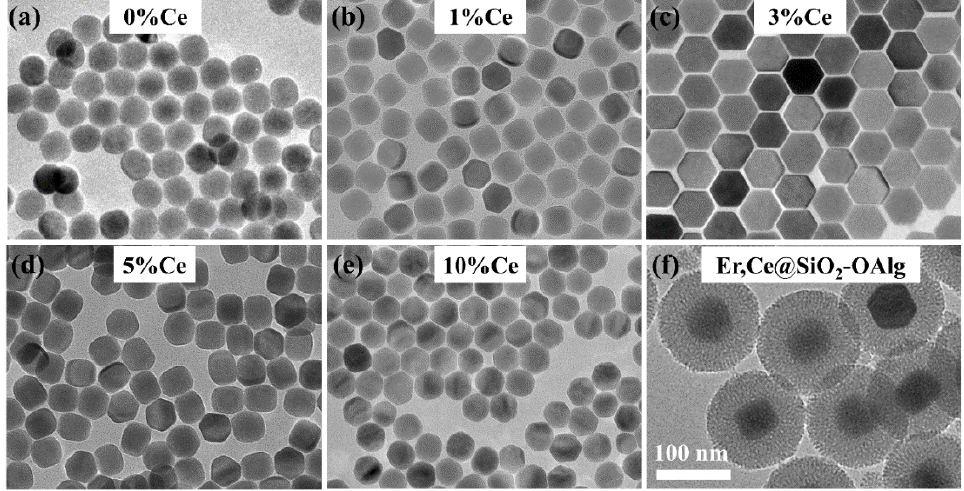
Figure 2. ( a – e ) TEM images of different NaYF 4 :20%Yb,2%Er,x%Ce (x = 0, 1, 3, 5, 10) nanoparticles. ( f ) TEM image of the NaYF 4 :20%Yb,2%Er,3%Ce@SiO 2 -OAlg (Er,Ce@SiO 2 -OAlg) nanoparticles. The scale bar is 100 nm.